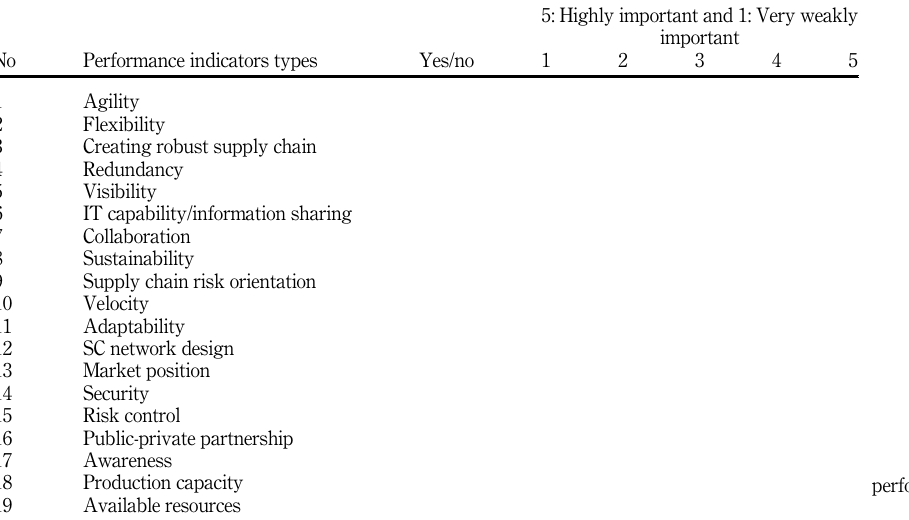
performance indicators of resilient